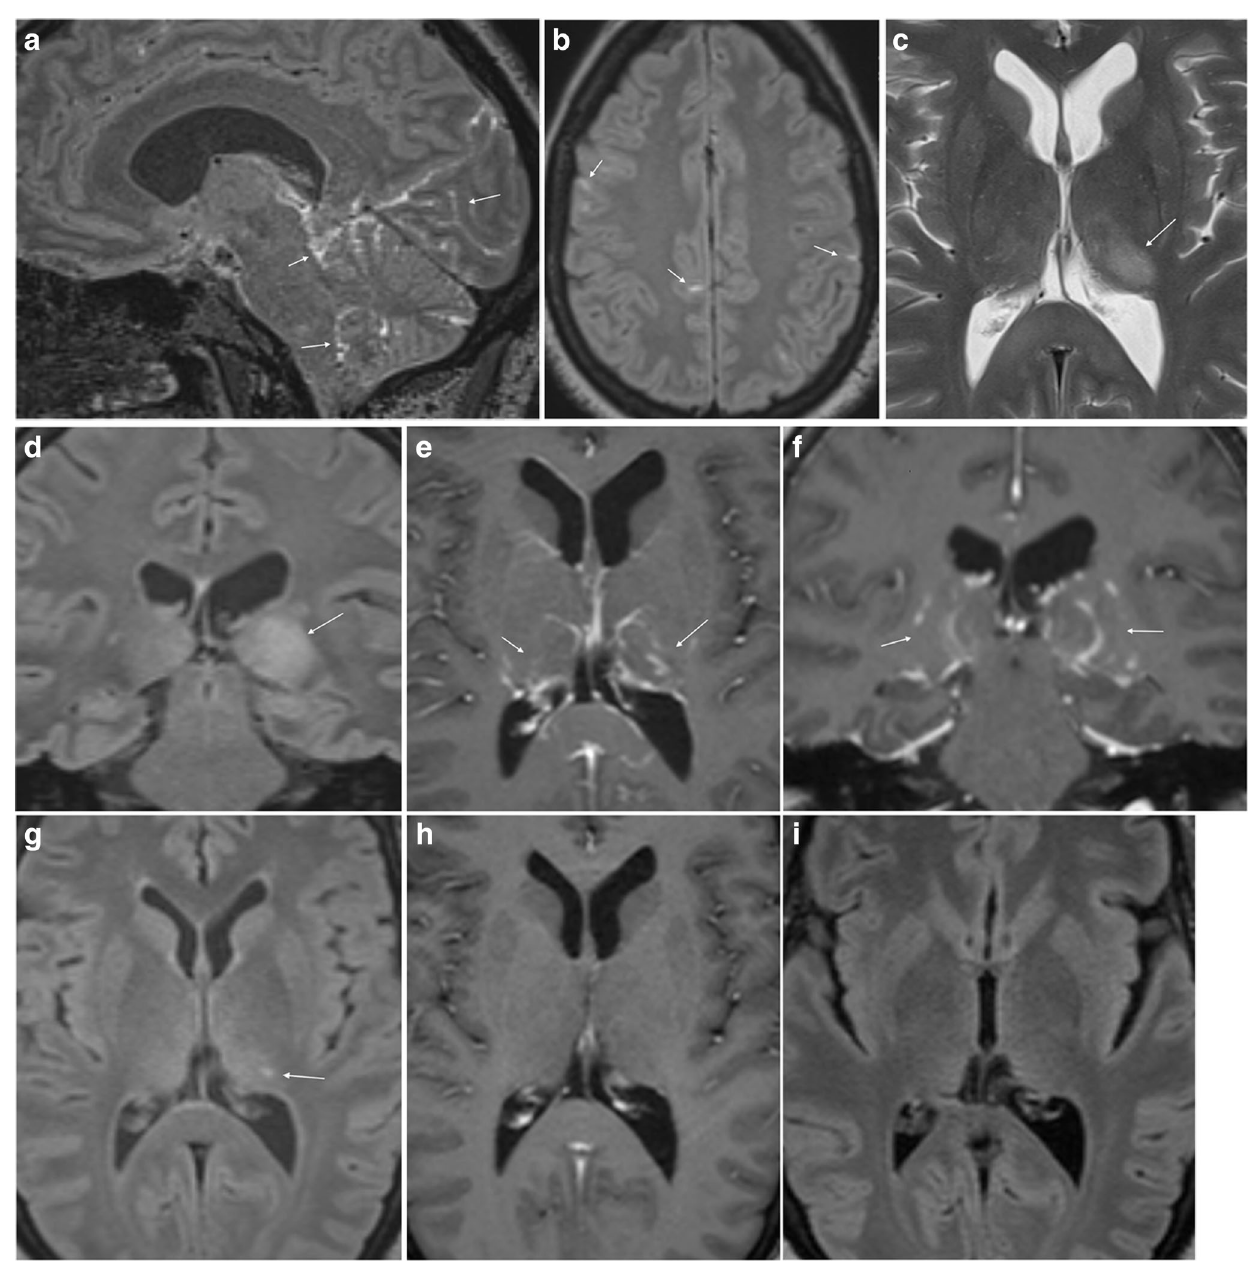
Fig. 5 LNB meningoencephalitis in a 45-year-old female who presented with fatigue, headache, dizziness and vomiting. Neurological findings were tremor and unsteady gait. The CSF cell count was 270 cells/mm 3 and there was a positive Bb IgG AI. Post-contrast sagittal ( a ) and axial ( b ) FLAIR images demonstrated patchy leptomeningeal enhancement over the cerebral convexities and in the posterior fossa (arrows). There was a hyperintense lesion in the left thalamus (arrow) on axial T2-weighted image ( c ) and coronal FLAIR image ( d ). There was no abnormality in